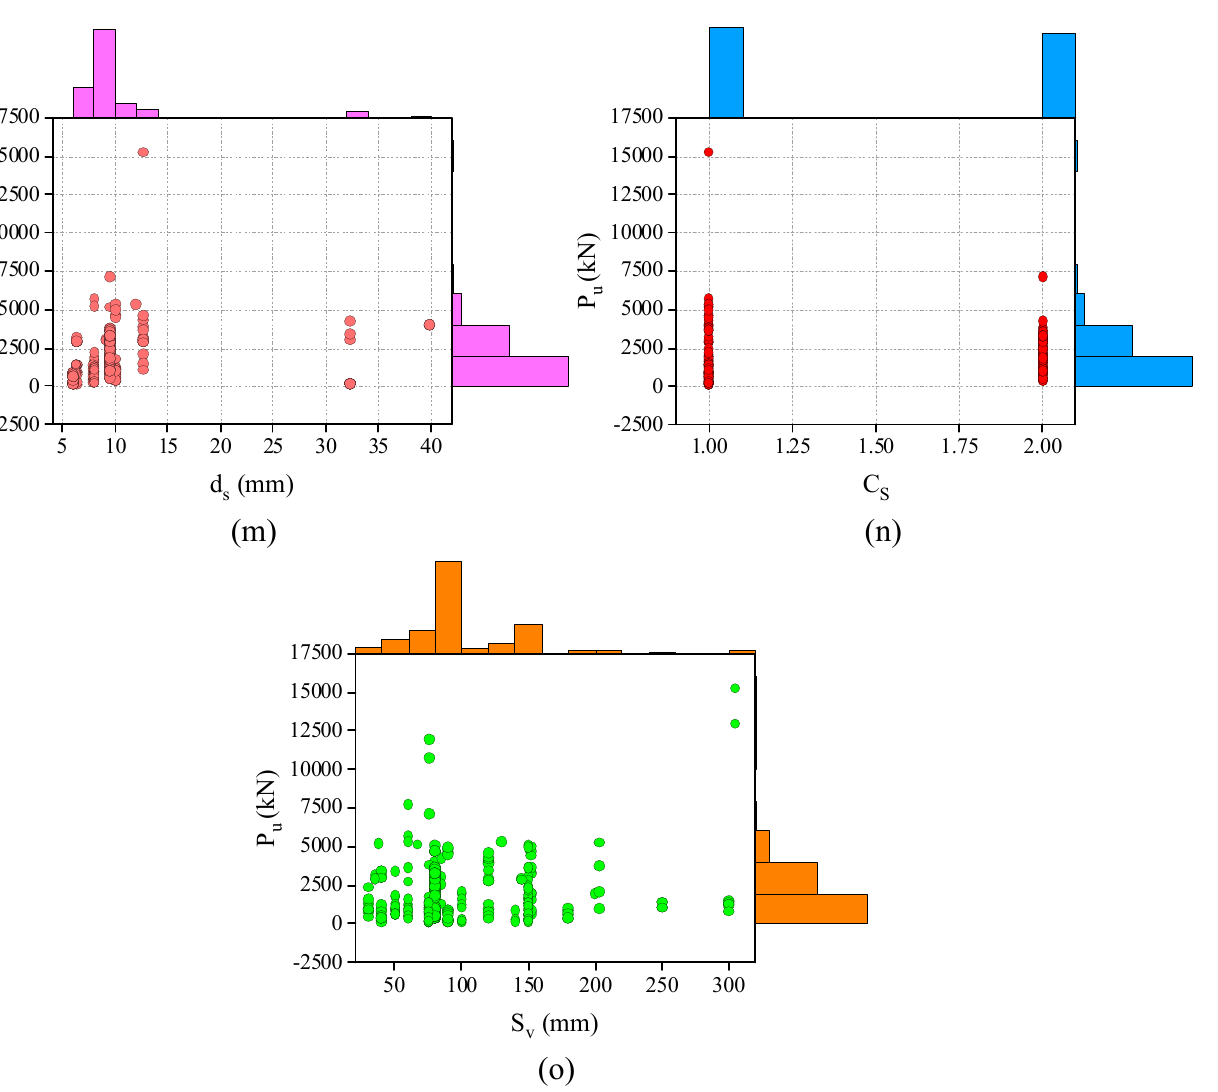
Figure 1. Distribution of the input and output variables: ( a ) height of specimen (H) , ( b ) gross cross- sectional area (A g ) , ( c ) type of concrete (C type ), ( d ) CS of concrete (f’ c ), ( e ) type of reinforcement (l type ), and ( f ) percentage of FRP reinforcement ( ρ FRP ) , ( g ) area of FRP reinforcement (A FRP ) , ( h ) no. of reinforcement bars (n), ( i ) diameter of main reinforcement bar ( d m ) , ( j ) elastic modulus of FRP ( E FRP ) bar, ( k ) tensile strength of FRP (f FRP ) bar, and ( l ) type of tie bar (t type ) , ( m ) diameter of stirrups (d s ), ( n ) configuration of stirrups (C S ), and ( o ) spacing of stirrups (S v )